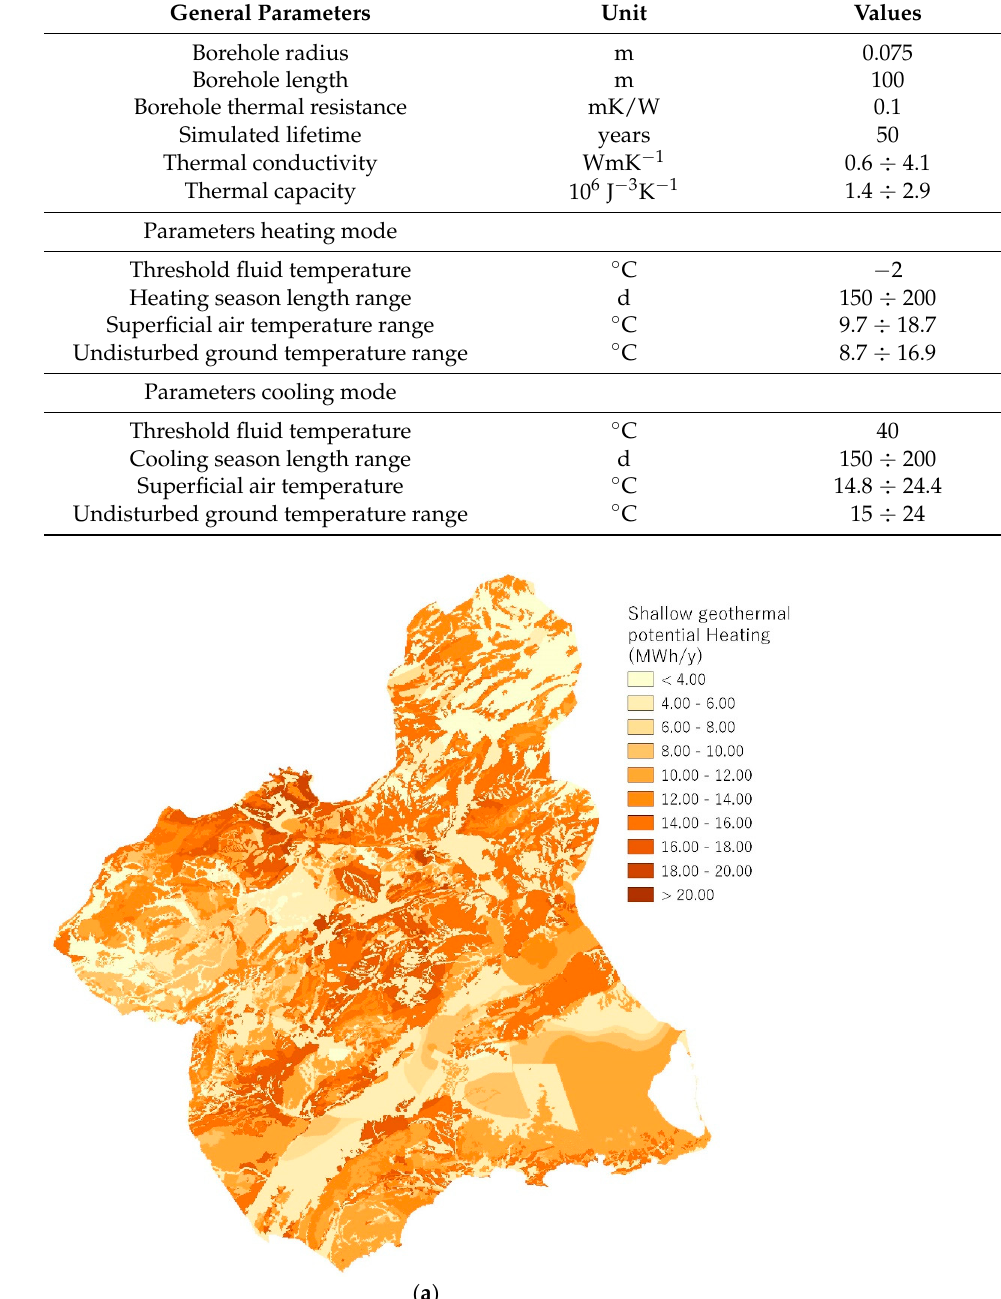
Table 1. Shallow geothermal potential assessment inputs.